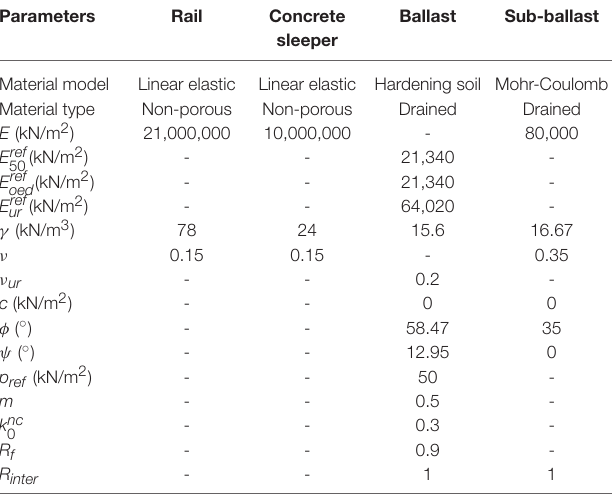
E = elasticity modulus, E ref 50 = secant stiffness at 50% strength for loading conditions, E ref ur = triaxial unloading/reloading stiffness, E ref oed = tangent stiffness for primary oedometer loading, γ = unit weight, ν = Poisson’s ratio for loading conditions, ν ur = Poisson’s ratio for unloading/reloading conditions, c = effective cohesion, φ = effective friction angle, ψ = dilatancy angle, p ref = reference confining pressure, m = stress dependent stiffness factor, k nc 0 = coefficient of earth pressure at rest for normal consolidation, R f = failure ratio and R inter = strength reduction factor in the interface.